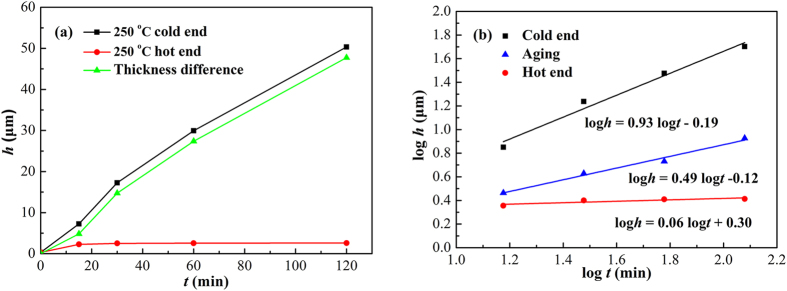
Thickness of interfacial Cu6Sn5 as a function of TM time at 250 °C: (a) h–t; (b) logh–logt.